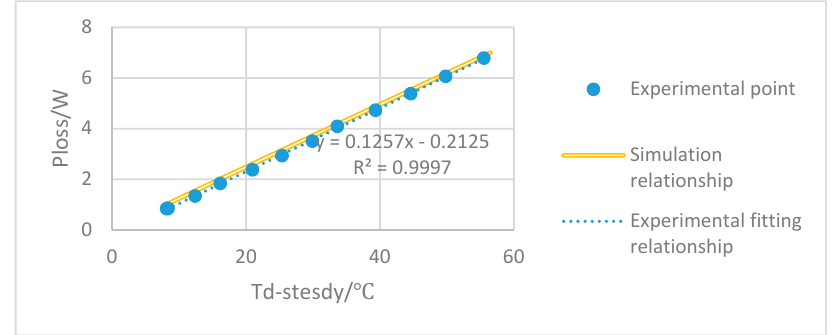
Figure 10. Simulation and experiment steady state temperature difference versus power of T1.